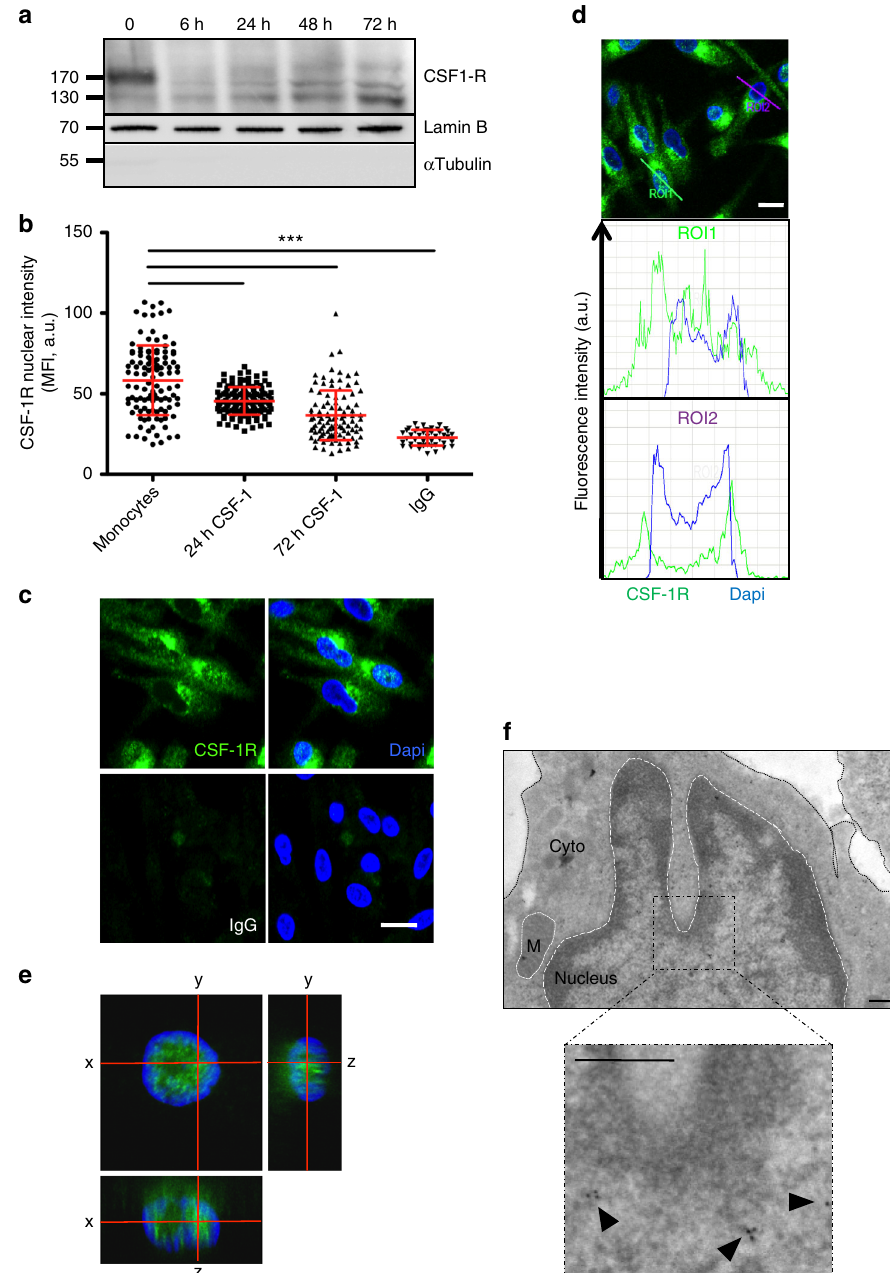
Fig. 6 Differential CSF-1R chromatin localization in CSF-1-induced macrophages. a Nuclear proteins were extracted from monocytes stimulated with 100ng/mL CSF-1 during the indicated times, and analyzed by immunoblotting for CSF-1R, Lamin B (nucleus marker) and α -tubulin (cytosol marker) ( n = 3). b Monocytes were stimulated or not with 100ng/mL CSF-1 during the indicated times, stained with an anti-CSF-1R antibody (Cter sc-692) or a control IgG and Dapi, followed by confocal imaging analysis of CSF-1R nuclear localization (MFI, mean fl uorescence intensity, A.U. arbitrary units, mean + / − SD, Paired t test: *** P <0.001, n = 1). c Monocytes were treated 3 days with 100ng/mL CSF-1, fi xed and stained for CSF-1R or control IgG (green) and Dapi (blue) followed by confocal imaging ( n = 3, scale: 10 μ m). d Quanti fi cation of the signal generated by CSF-1R labeling (green) and Dapi labeling (blue) according to indicated axes (A.U.: arbitrary units, ROI: region of interest, scale: 10 μ m). e Macrophages were stained with an anti-CSF-1R antibody (C-ter sc-692) and Dapi (blue), followed by confocal imaging analysis (stack of 50 pictures of 0.2 μ m) to reconstitute an orthogonal view (scale: 10 μ m). f Monocytes were differentiated 3 days with 100ng/mL CSF-1, fi xed and stained for CSF-1R (sc-692) followed by electron microscopy ( n = 1, scale: sites identi fi ed in macrophages, e.g., PU.1 TSS, while some CSF- (transcription termination site) and 5 ′ UTR regions compared 1R localizations as CSF2RB TSS were only transiently detected in with unstimulated monocytes (Fig. 8a, b). The fraction of CSF-1R cells treated for 6 h with CSF-1 (Fig. 8c). Pathway analysis indi- peaks colocalizing with H3K4me3 after 6 h of CSF-1 exposure cated that CSF-1R localizes mainly to genes involved in CSF-1 was 90% (Supplementary Data 13). Only 28% of CSF-1R peaks signaling, phagocytosis, and migration (Supplementary Table 3). remained similar to unstimulated cells (Fig. 8c and Supplemen- Most of these pathways differ from those identi fi ed in resting tary Data 14). CSF-1R was detected on a fraction of chromatin